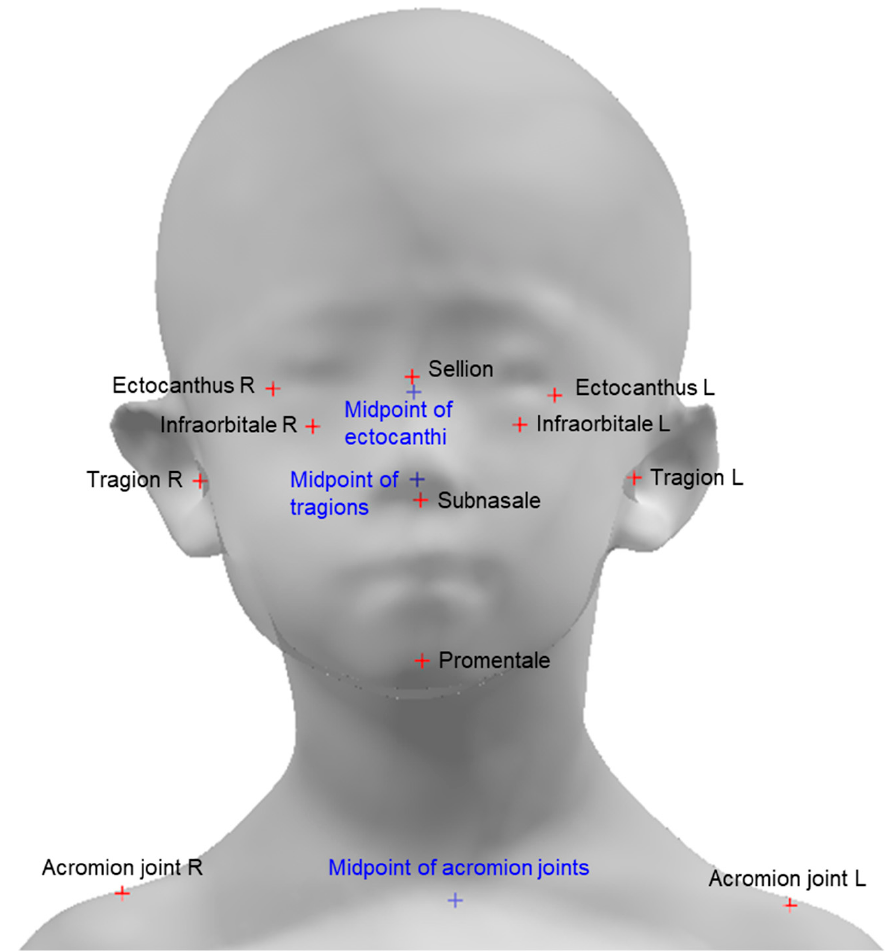
Figure 3. Landmarks for head angle analysis. The measurements were made for 20 s using a 3D scanning system, and the machine created a progressive sequence of 3D head images at 10 frames per second. In this study, a direction vector for head deviation measurement was calculated using each 3D head image taken, and the most frequent value among the measured values was used for analysis. The reference vectors in a neutral posture for comparison with the direction vectors representing the head deviation of the participants were generated using 3D head shapes and landmark information. Vertical vectors (0, 1, and 0) were created as a reference for